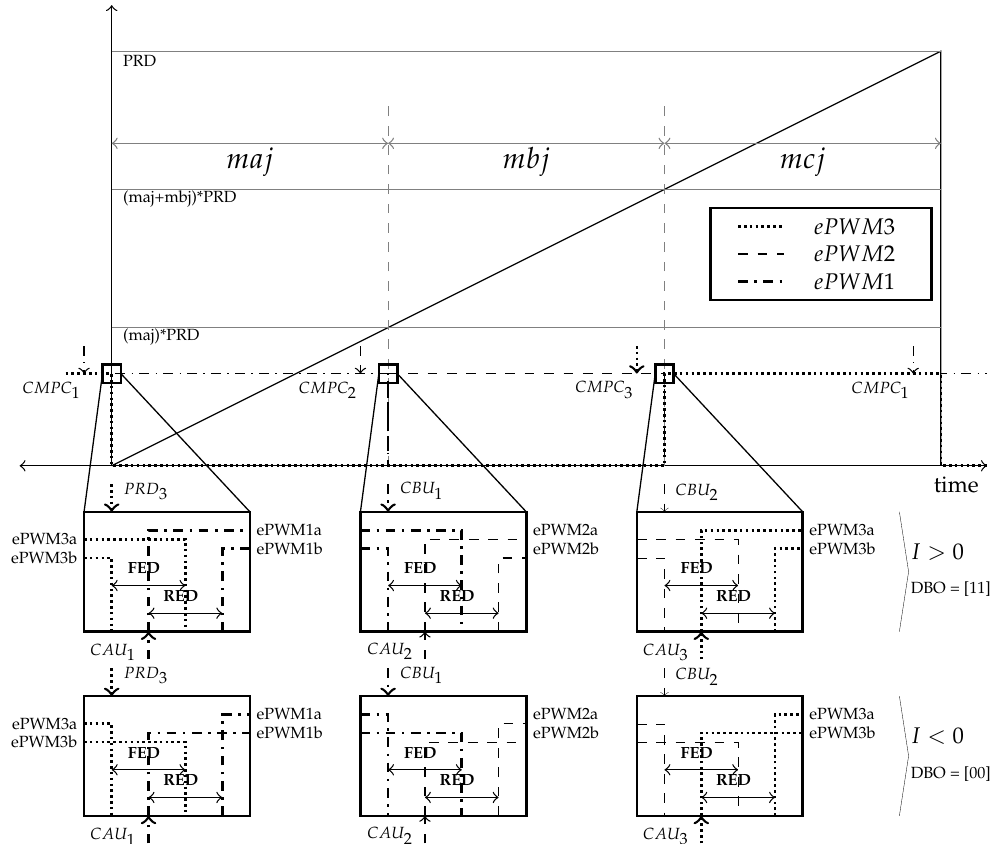
Figure 9. Four-step ePWM configuration and logical signals. DBO,